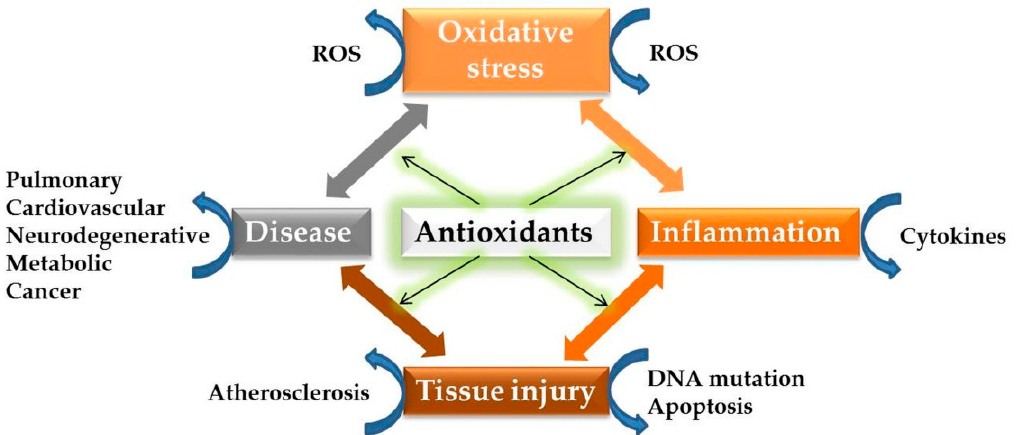
Figure 3. Effectiveness of antioxidants in the disease-specific pathways.